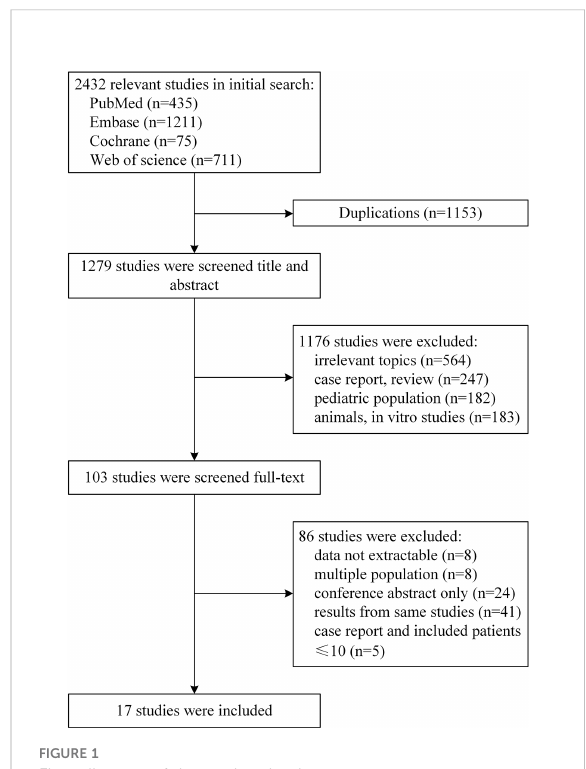
FIGURE 1 Flow diagram of the study selection